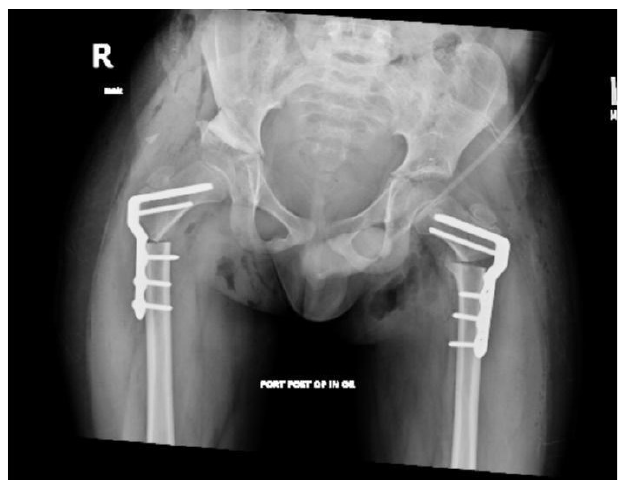
Figure 3 . Immediate Postoperative X-Ray After Initial Hip Surgery. The Bones Have Been Spliced and Conjoined with